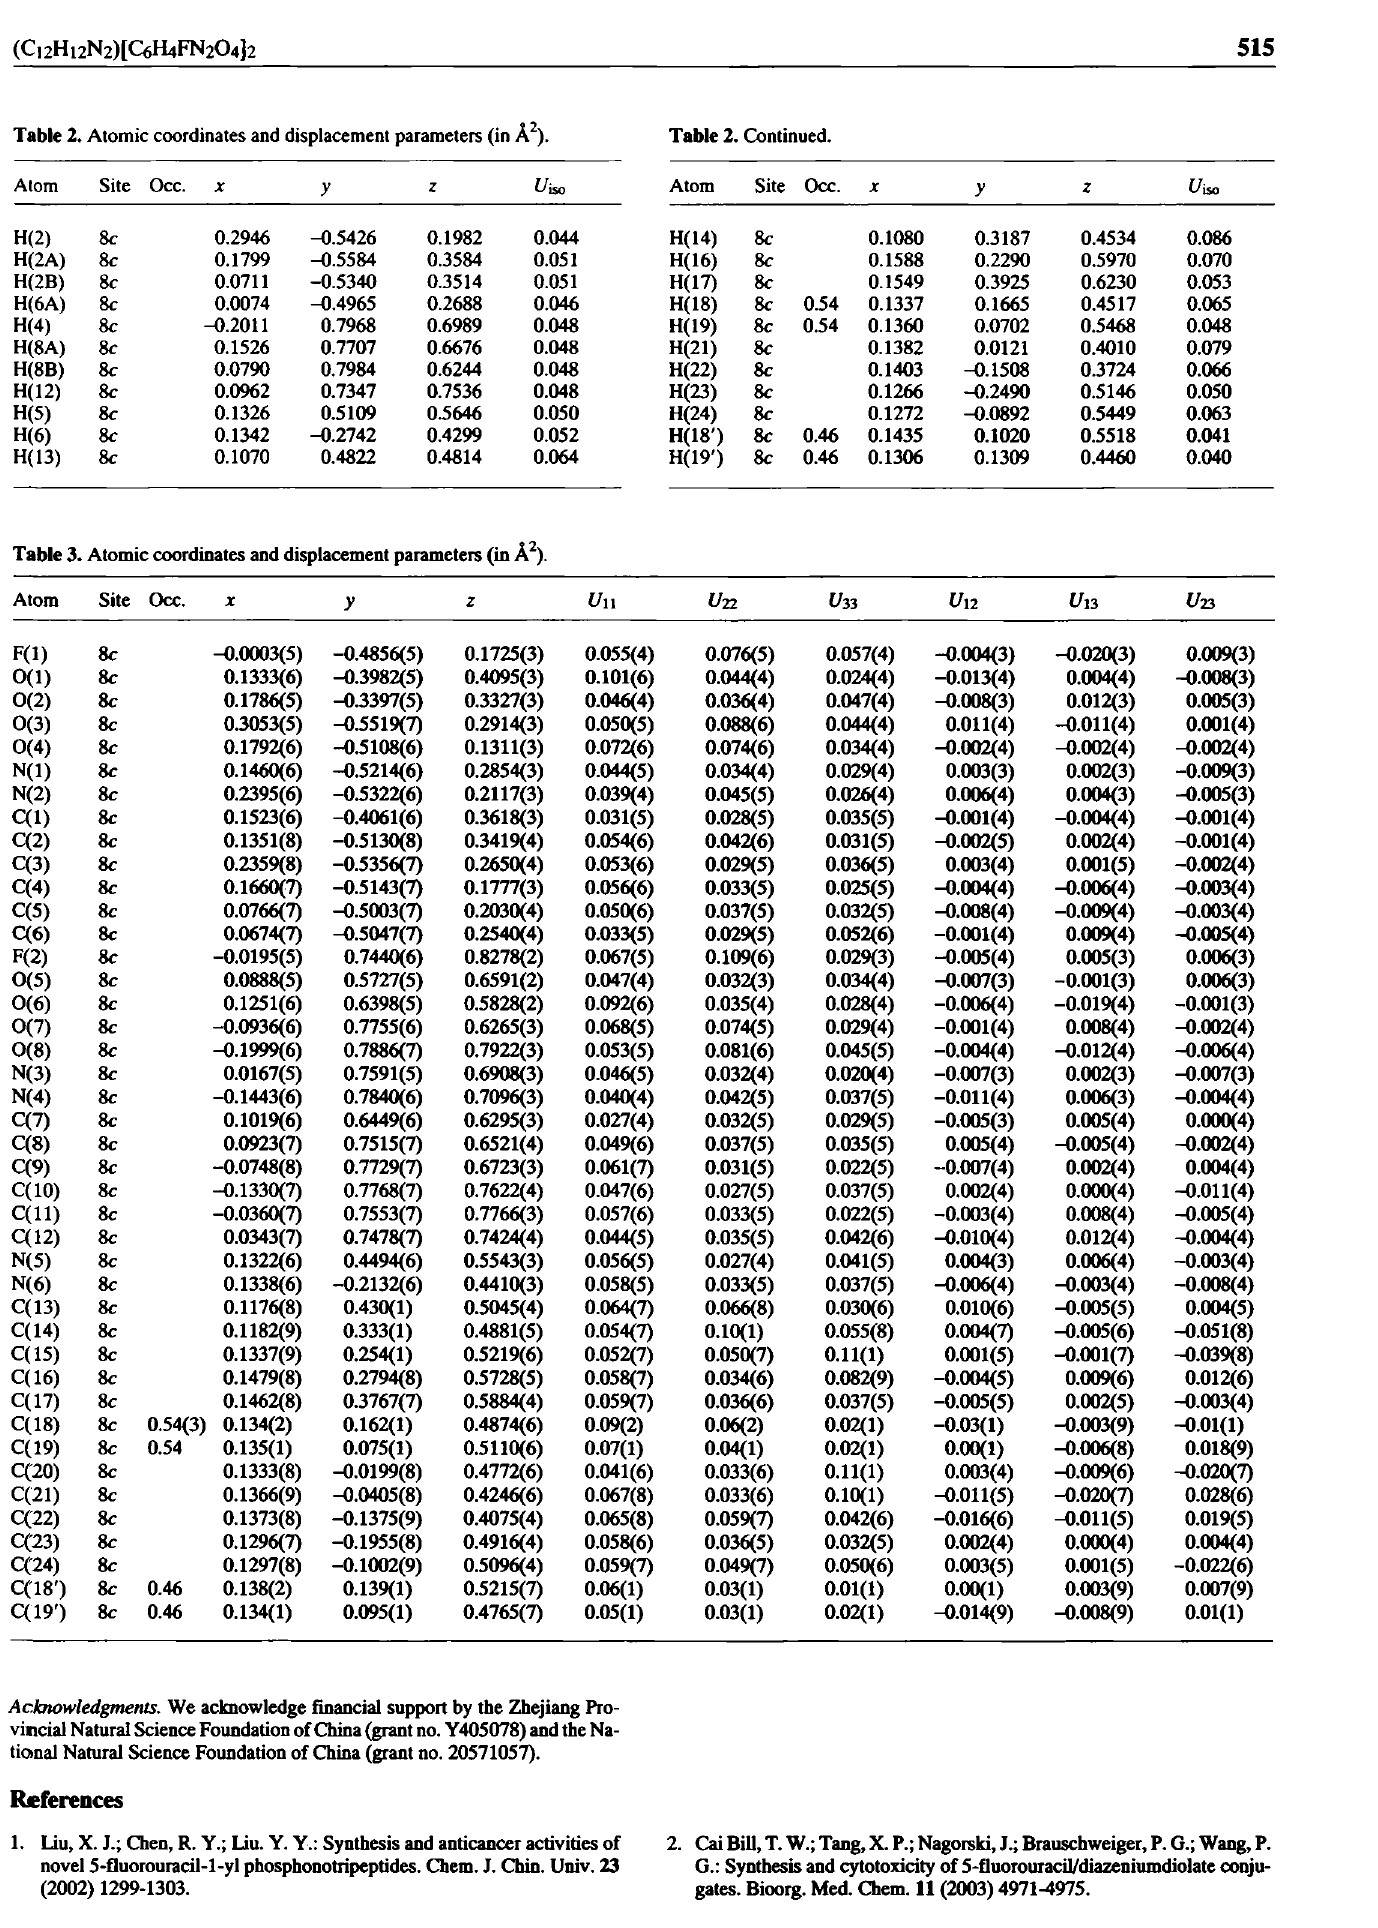
Table 2. Atomic coordinates and displacement parameters (in A 2 ).